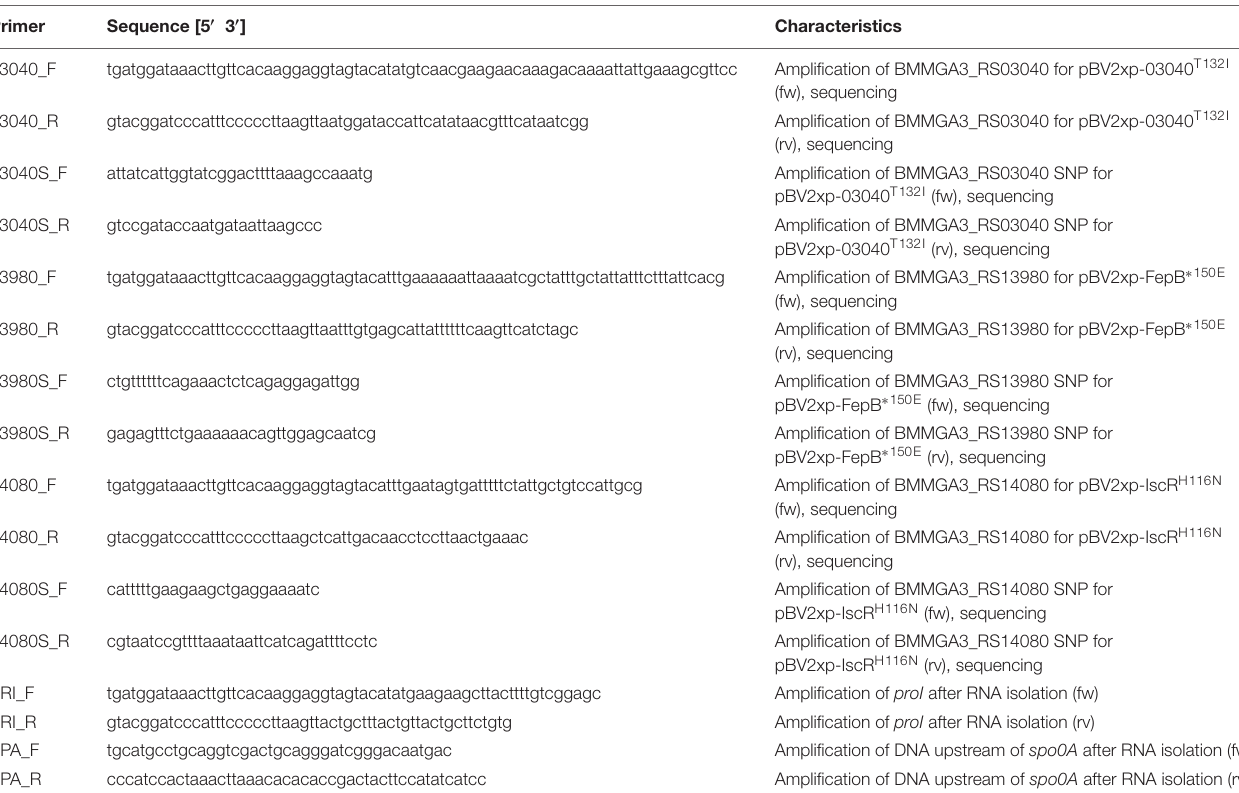
TABLE 2 | Primer sequences used in this